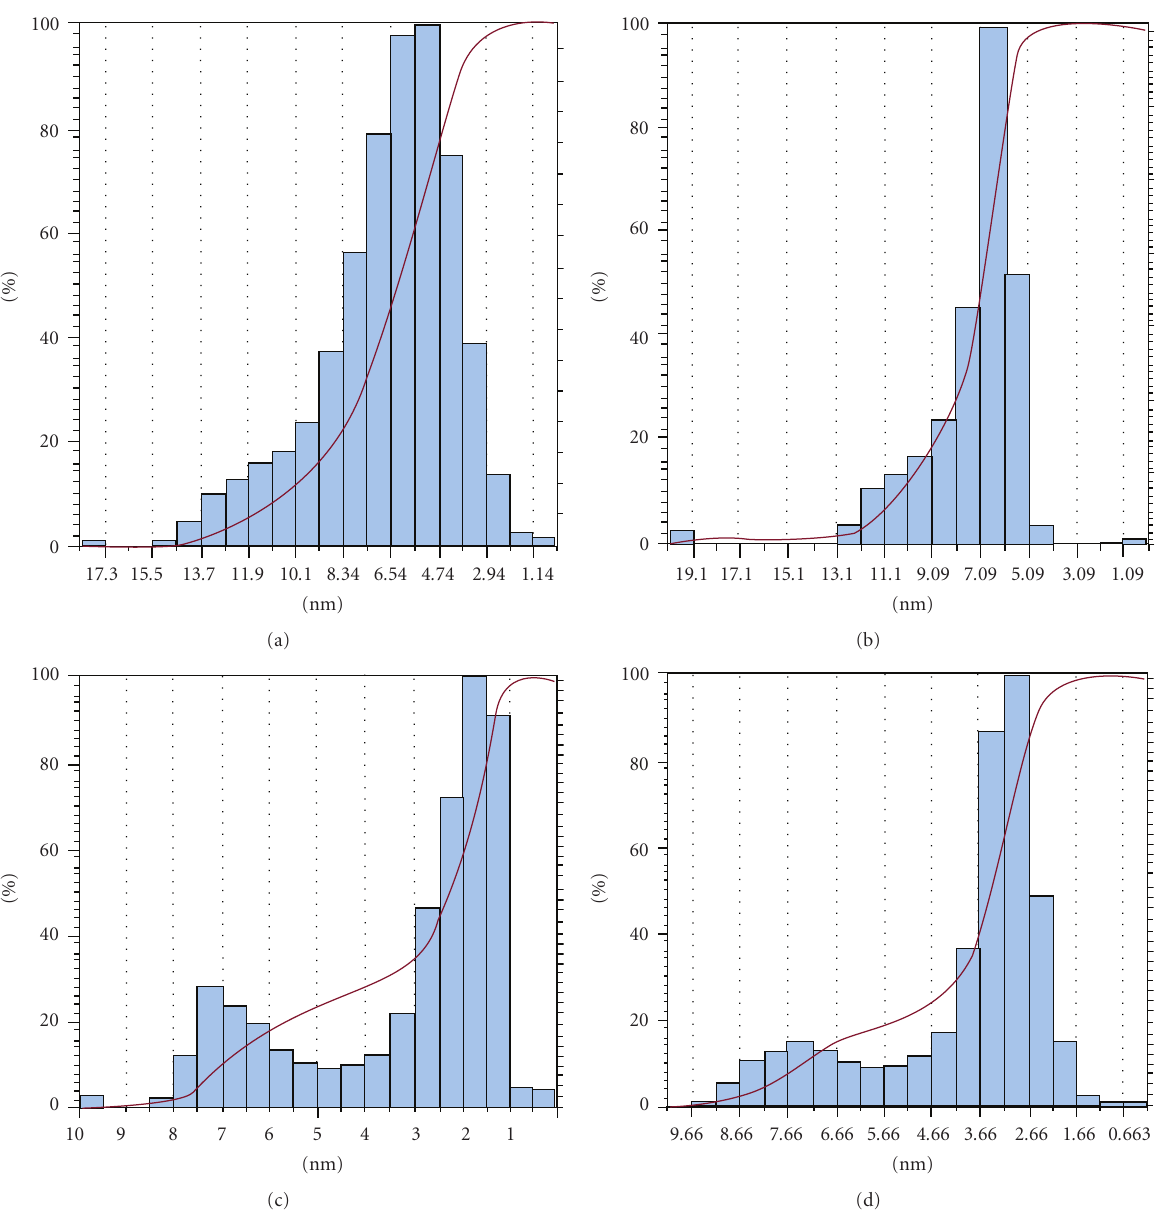
Figure 8: Histogram representing height of fibrils or particles versus percentage of fibrils or particles for (a) pure A β (1–42), (b) DHLA- capped QDs, (c) A β (1–42) mixed with DHLA-capped QDs, and (d) A β (1–42) conjugated to DHLA-capped